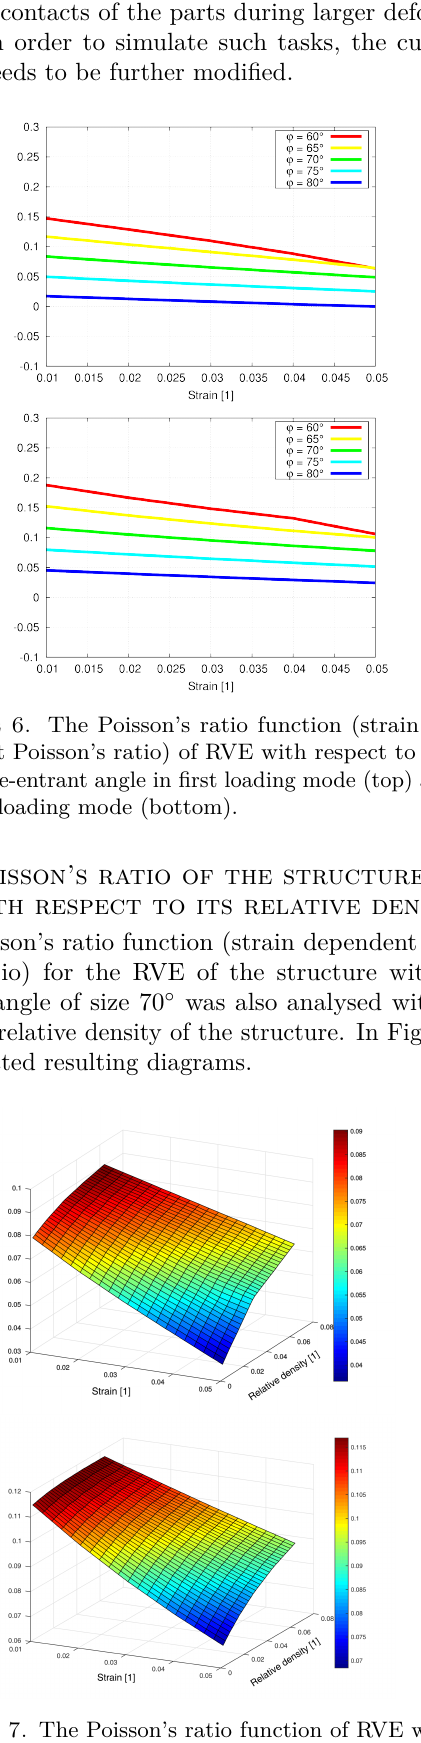
Figure 7. The Poisson’s ratio function of RVE with respect to the relative density of the structure